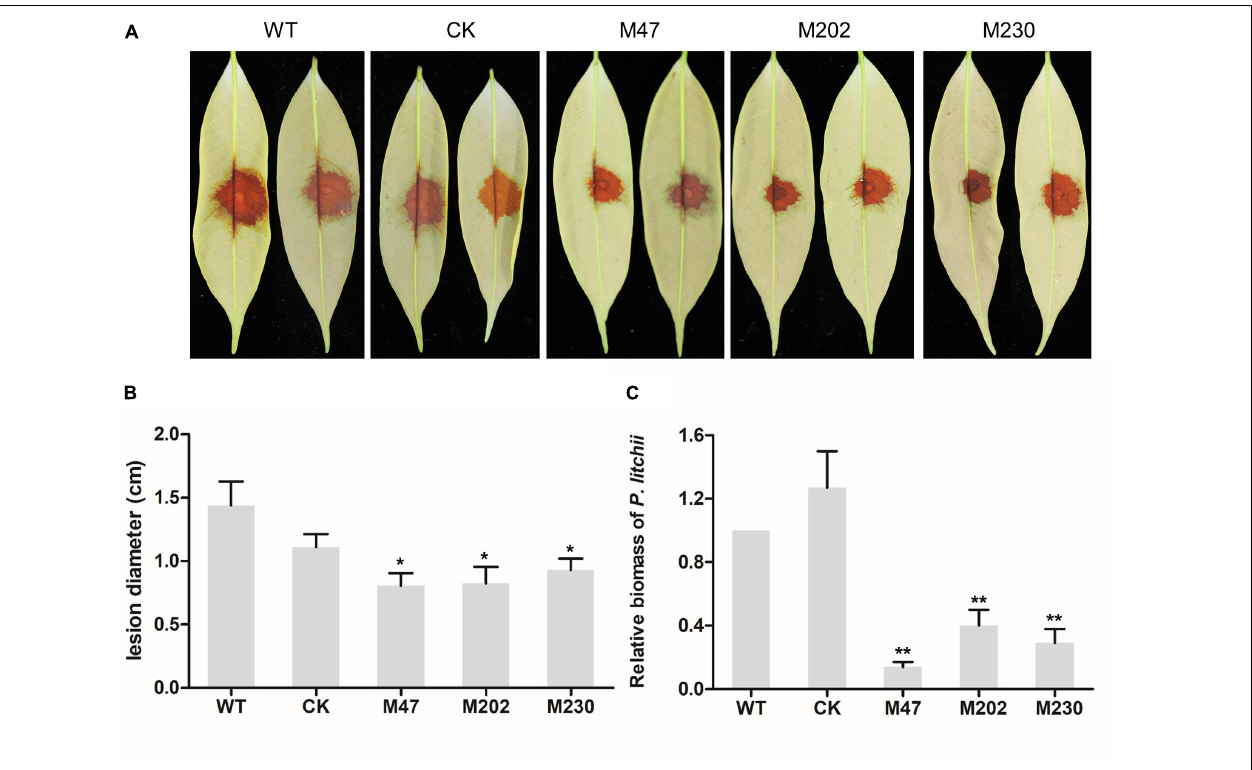
FIGURE 5 | Pathogenicity test of P. litchii (cid:49) plcb5l1 mutants, WT and CK. (A) Litchi leaves were inoculated with 200 zoospores of WT, CK, three (cid:49) plcb5l1 mutants M47, M202, and M230 for 48 h at 25 ◦ C in the dark. Images showed representative leaves for each instance. (B) Lesion lengths were measured 2 dpi. Data are mean ± SD ( n = 9) (* p < 0.05; Duncan’s multiple range test). (C) Relative P. litchii biomass was measured to evaluate the severity of infection by qRT-PCR. Data are mean ± SD ( n = 9). Asterisks represent significant difference (** p < 0.01; t -test range